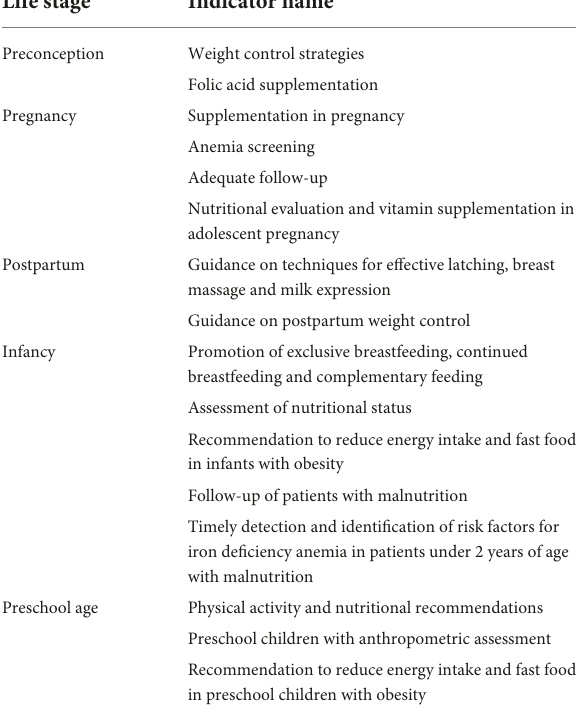
TABLE 4 Final selected indicators to assess the quality of maternal and child nutritional